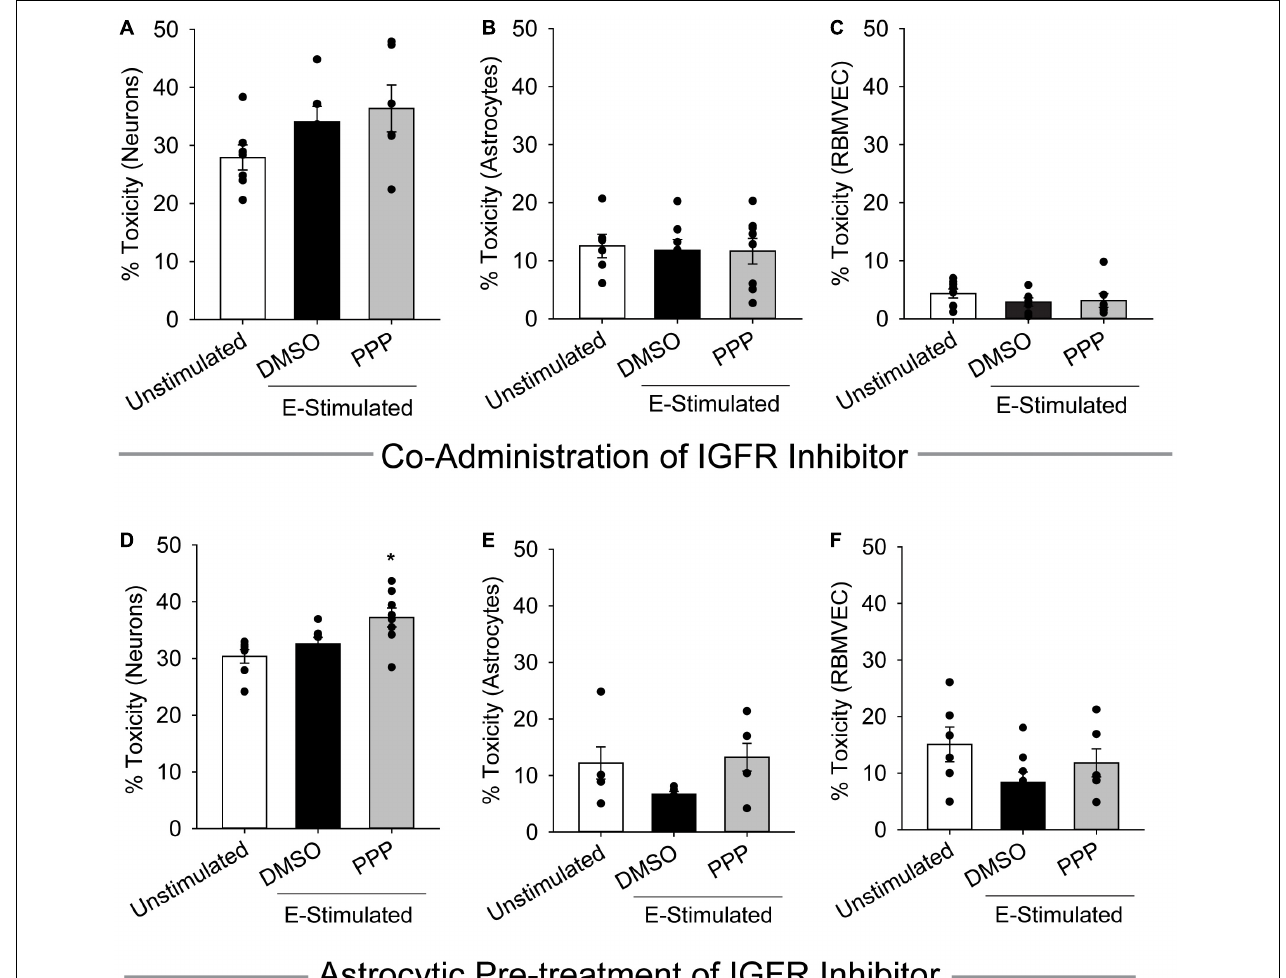
FIGURE 3 | Astrocytes fail to protect against excitotoxicity when IGFR is inhibited. Average cell death 24 h after triple cultures of neurons (A) , astrocytes (B) , and endothelial cells (C) were co-administered 0.5 µ M PPP and 100 µ M glutamate for 1 h ( n = 6–8 wells/group). One-way ANOVA failed to detect differences in any of the treatment groups. (D–F) Astrocytes were pre-treated with 5 µ M PPP for 24 h prior to combining with endothelial cells and neurons for a triple culture system. Average cell death in the neurons (D) , astrocytes (E) , and endothelial cells (F) after stimulation with 100 µ M glutamate for 1 h ( n = 5–8 wells/group). One-way ANOVAs with post hoc Bonferroni comparison was used for statistical analyses. *indicates significant difference between control and PPP-treated glutamate-stimulated neurons. All data are presented as mean ± SEM, n = 5–8 wells/treatment